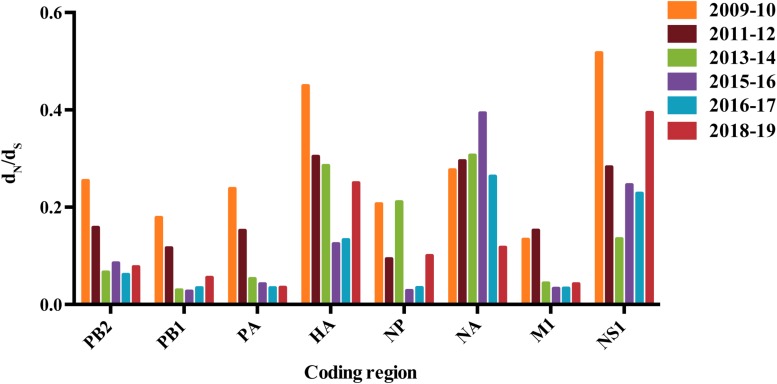
The dN/dS values for major genes of A/H1N1pdm virus. Colored bars correspond to different years. This dN/dS value represents an average over all sites and lineages.